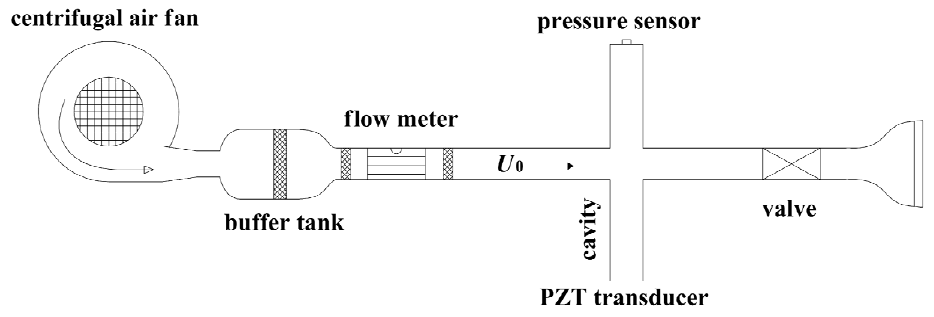
Figure 3. Schematic diagram of experimental setup.